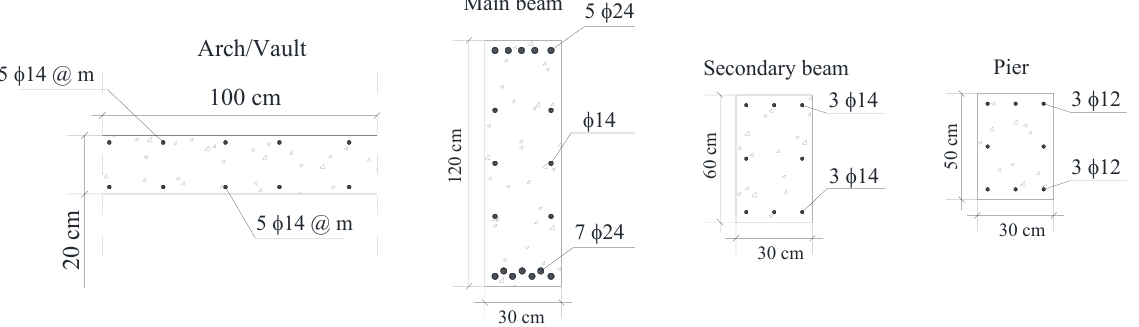
Figure 5. Details of cross section and steel reinforcement of di ff erent structural elements.